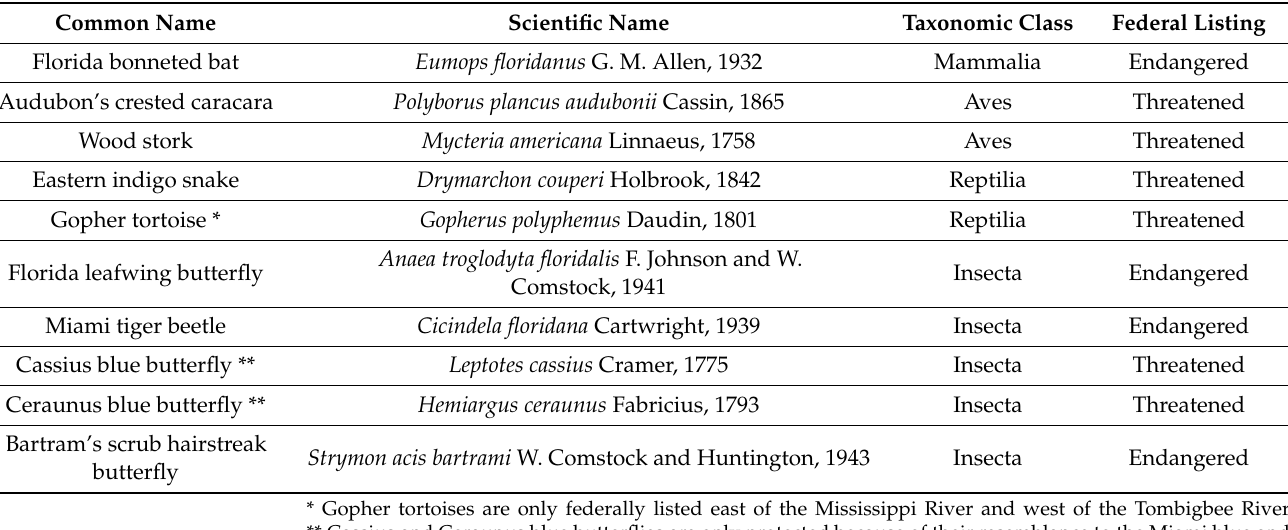
Table 4. List of federally listed animals that occupy the Richmond pine rocklands.